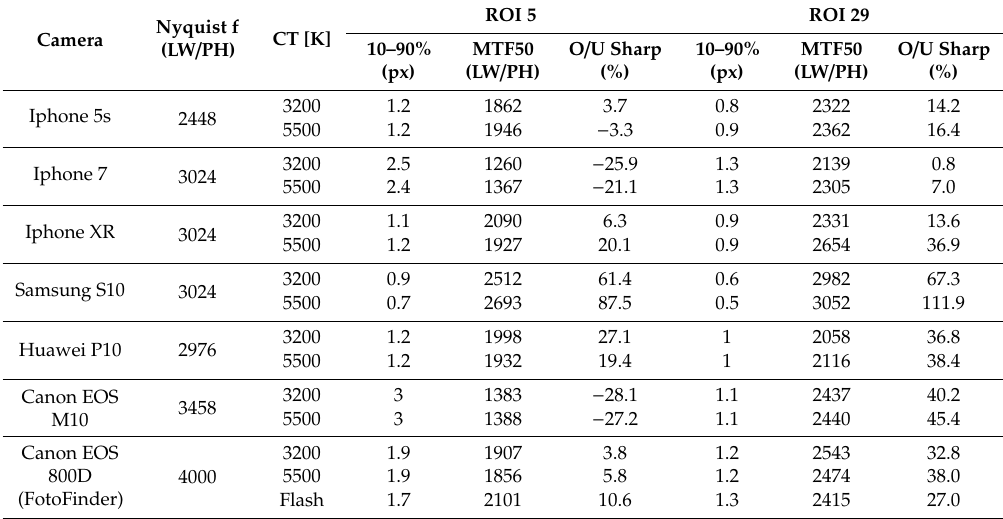
Table 2. Cameras’ sharpness results for the Imatest ® eSFR test chart.